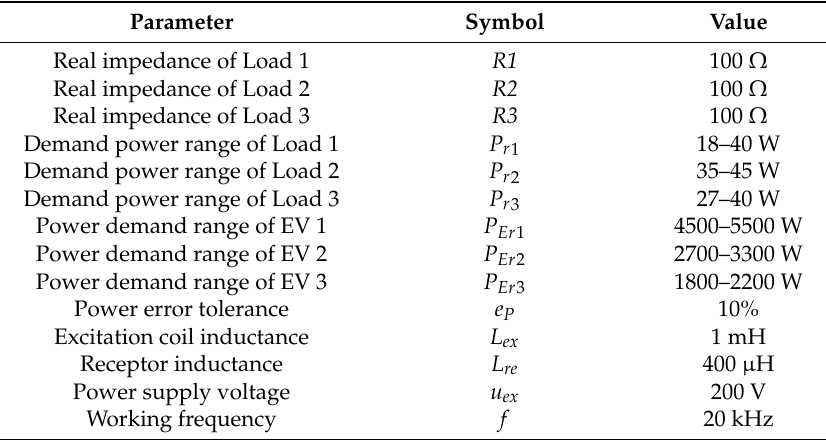
Table 1. Key parameters.